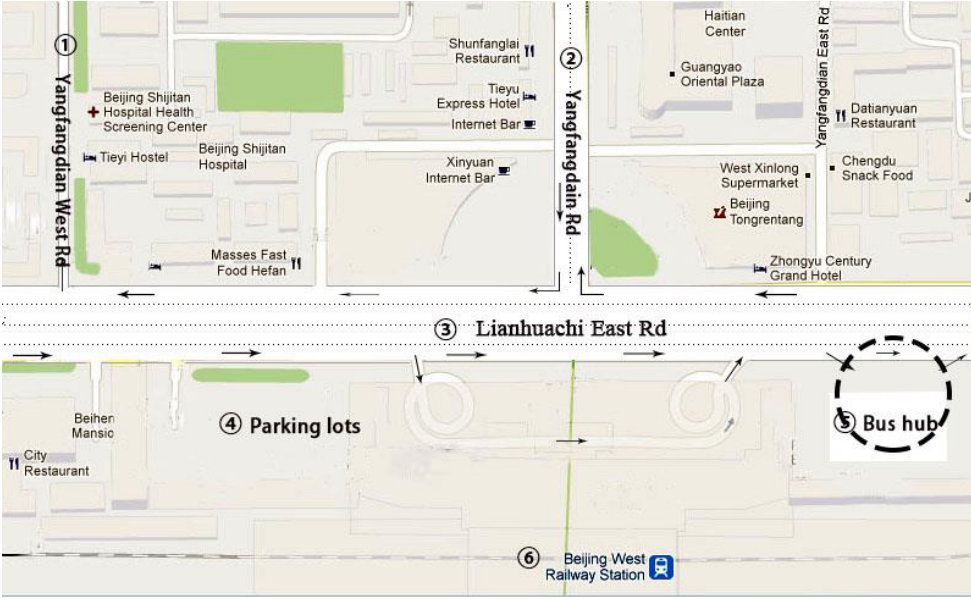
Figure 3. The 2 nd Congestion Point on Lianhuachi East